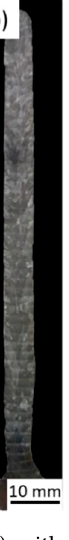
Figure 6. Macrostructure of samples produced: ( a ) with secondary heat source and ( b ) without (adapted from [34]).